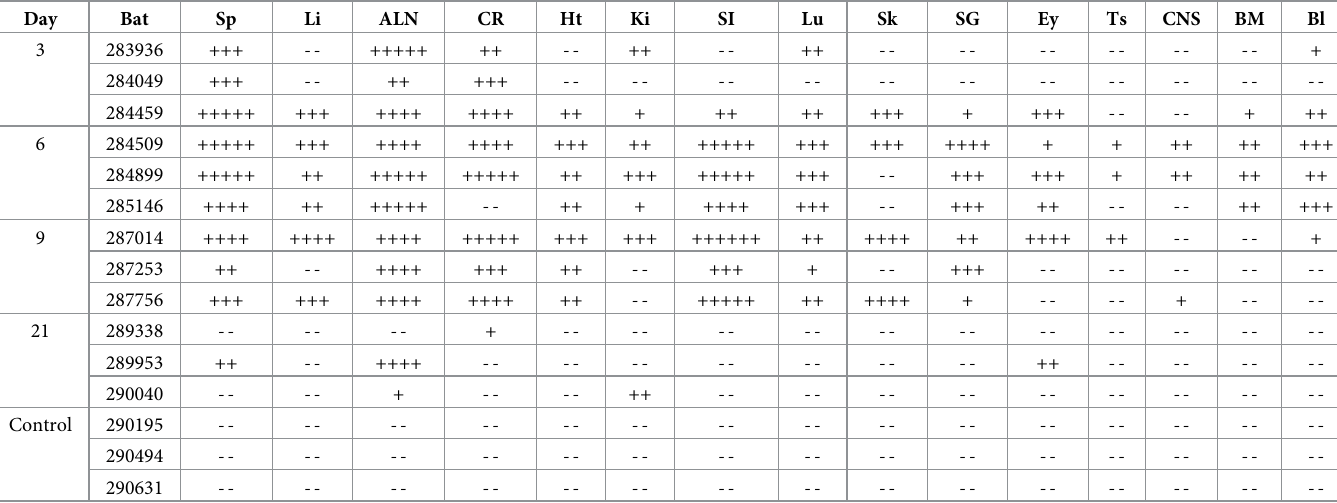
Table 1. Tissues qRT-PCR positive for Sosuga virus